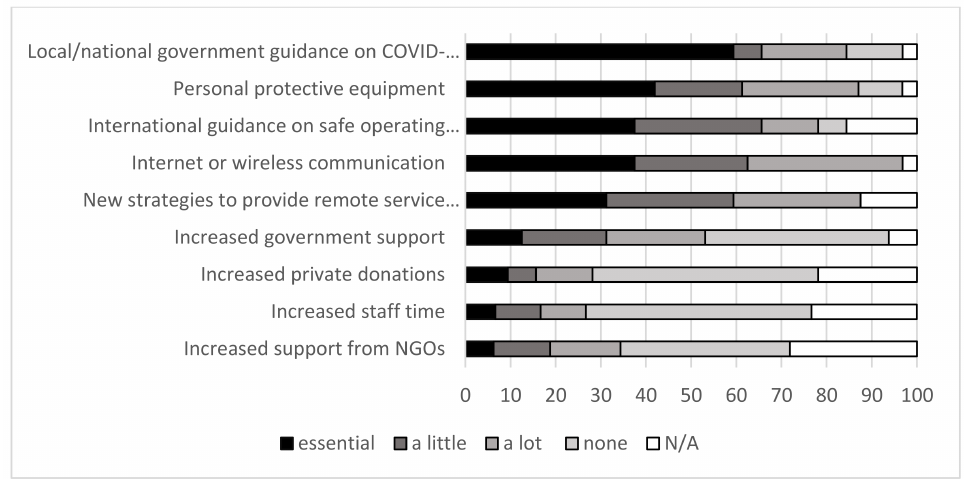
Figure 6. Things that assisted in responding to COVID-19 to maintain assistive technology